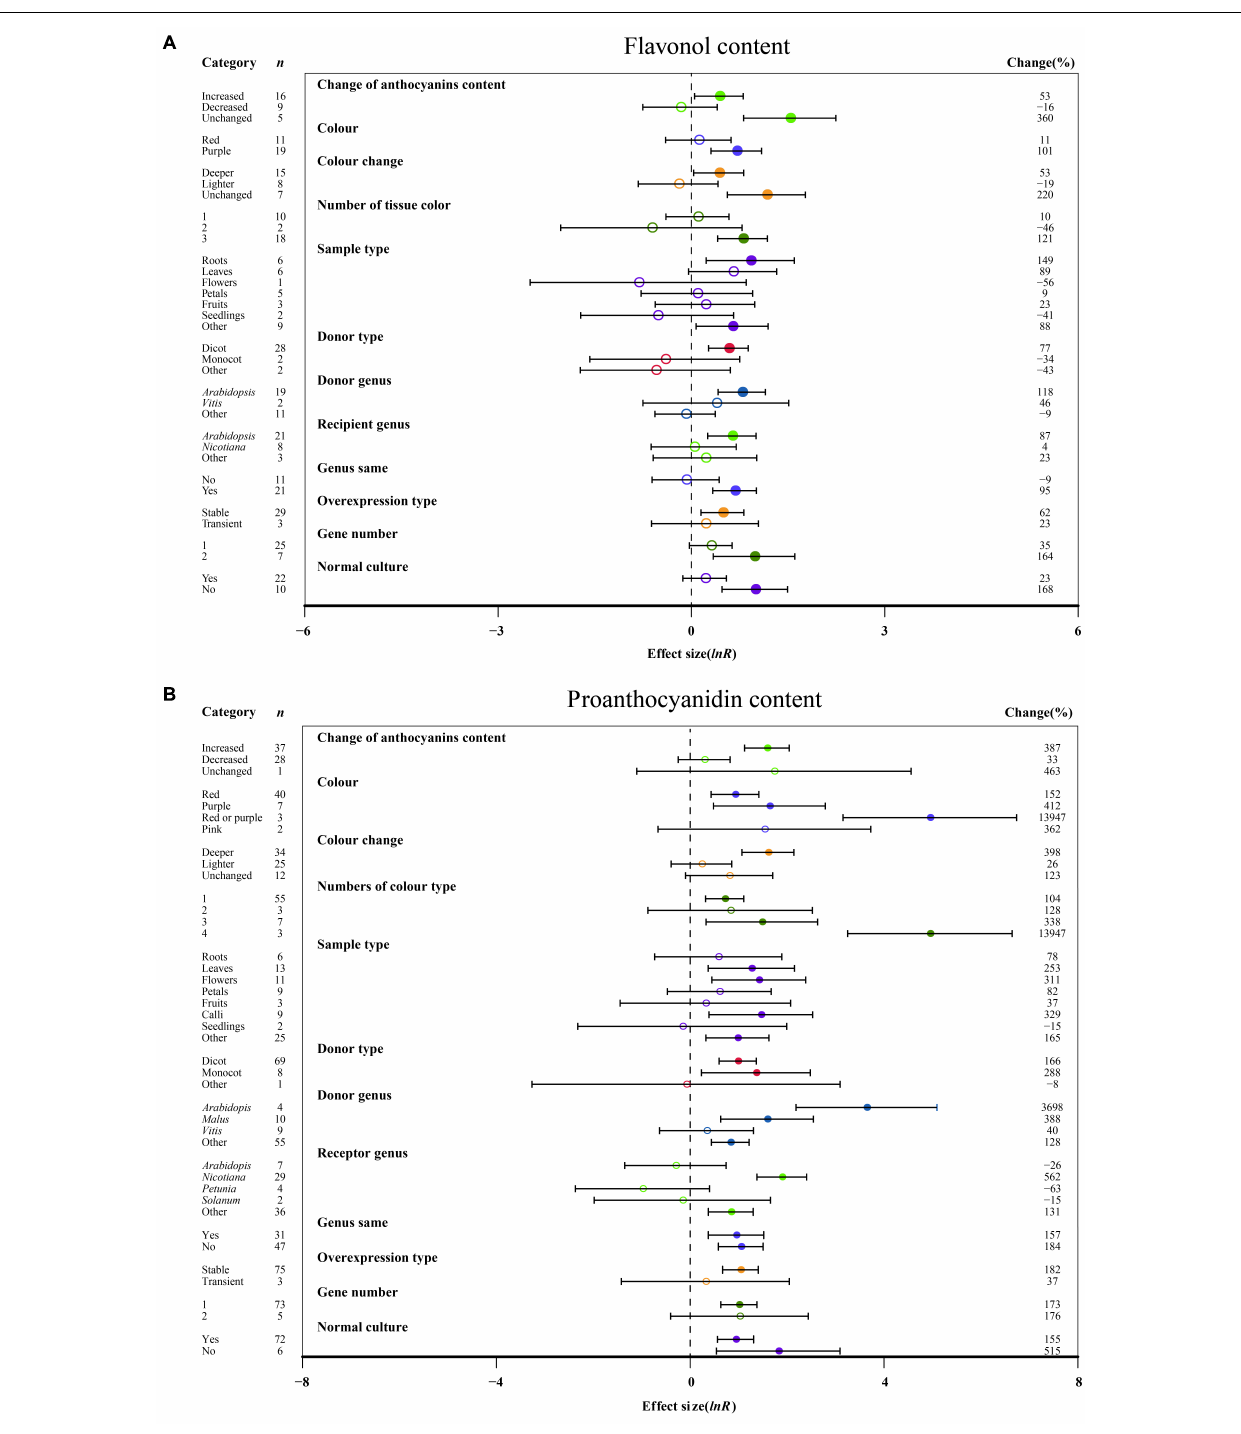
FIGURE 3 | Summary effects (ln R ) of the influence of MYB overexpression on the contents of flavonol (A) and proanthocyanidin (B) in plants. Ratios are unit-less. The ratios illustrate the strength of MYB overexpression on the summary effects of the flavonol and proanthocyanidin contents compared with the controls. Circles and horizontal bars indicate the summary effects and the 95% CI of twelve (A) owing to insufficient studies, “recipient type” not analyzed) and twelve (B) owing to insufficient studies, some moderators not analyzed) moderator variables, respectively. n represents the number of studies. Subgroup list levels (subgroups or categories) of each moderator. The percent change (to the right of plots) refers to the raw percentage increase or decrease in the content of flavonol and proanthocyanidin induced by overexpression of MYB . The moderator variables of the examined plants are colored and distinguished by different colors. Closed and open circles indicate the effects of significance and insignificance,